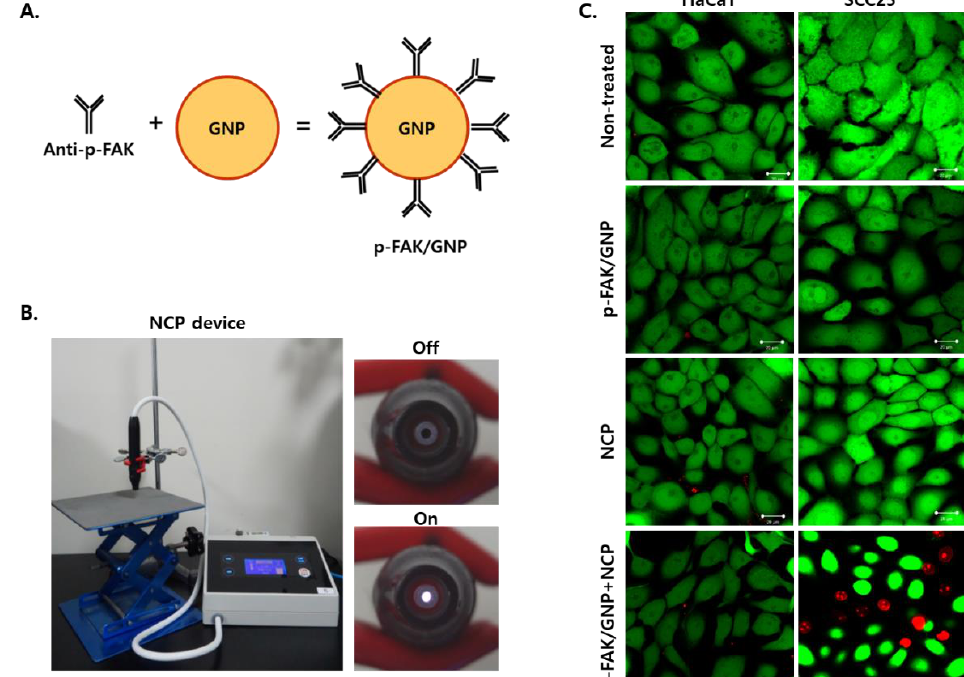
Figure 2. The combinational treatment of NCP with p-FAK/GNP selectively and immediately kills SCC25 cells. ( A ) A schematic diagram for the conjugation of p-FAK antibodies with GNP to form p-FAK/GNP. ( B ) Photographs showing the NCP device used in this study. ( C ) The results of the live/dead assay. The cells were treated with NCP, p-FAK/GNP and in combination, as described in the Materials and Methods section. The assay was performed immediately after the NCP treatment. The photographs are representative of the 3 independent experiments. Scale bar: 20 μm.